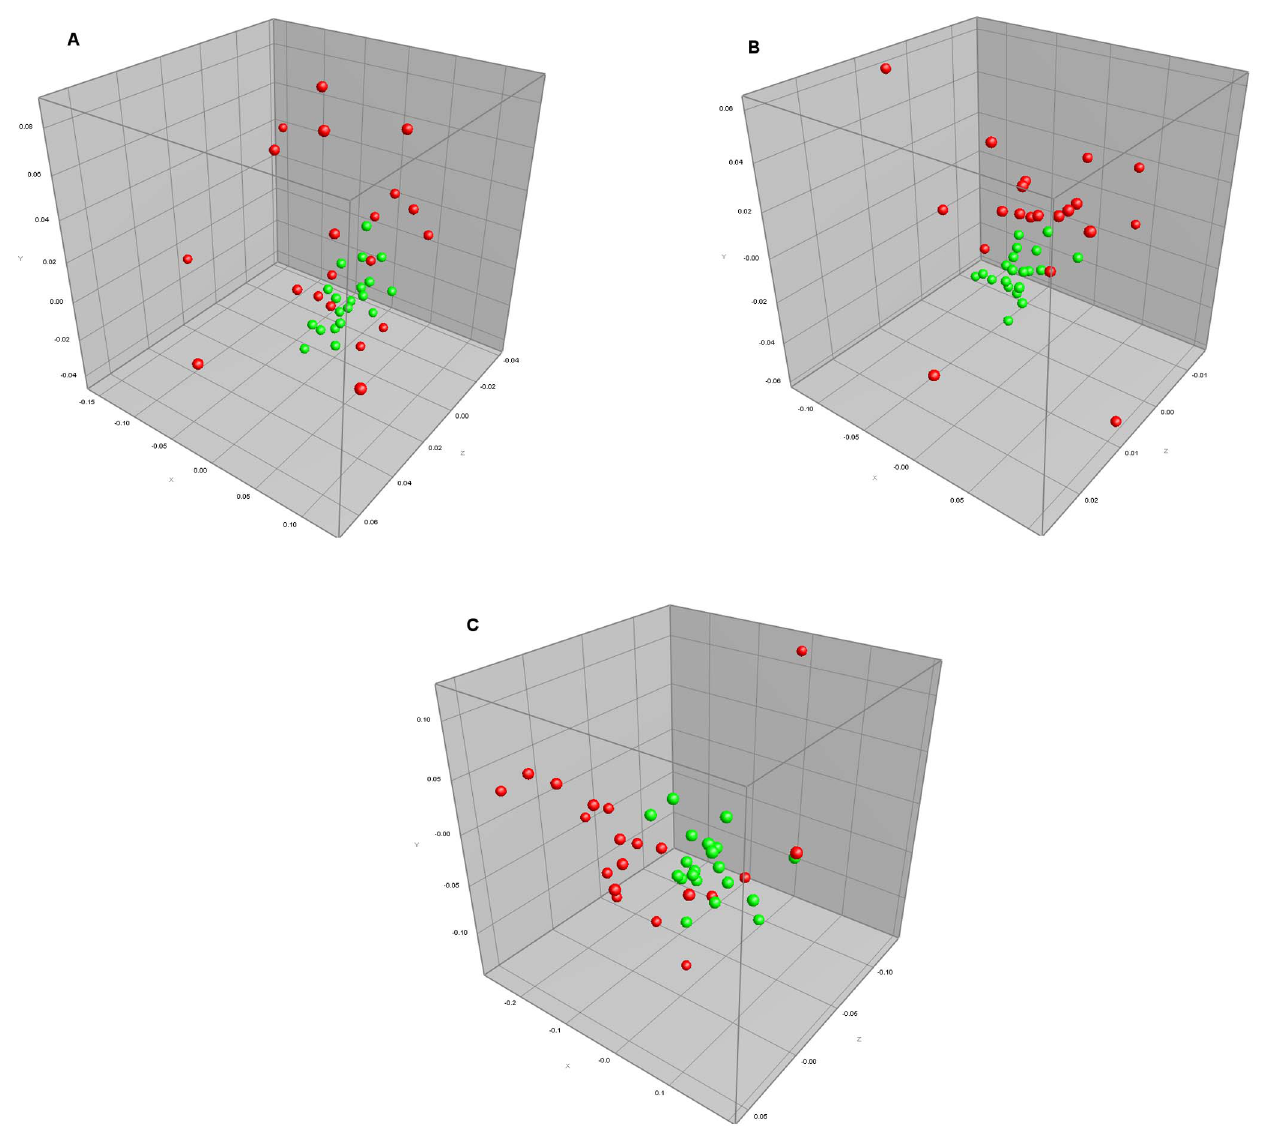
Figure 5. Multidimensional scaling (MDS) representation of spectrum reproducibility. MDS representing reproducibility associated with spectra of P. aeruginosa (A), K. pneumoniae (B) and S. marcescens (C) acquired via non-optimized (red) and optimized (green)